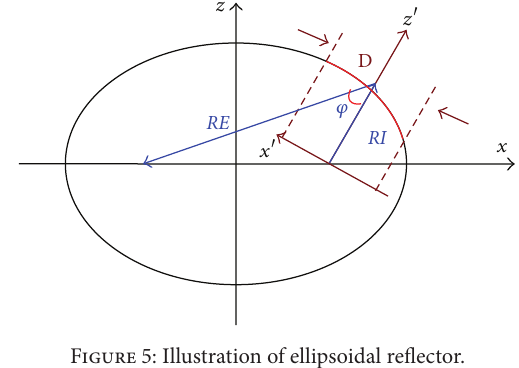
Figure 5: Illustration of ellipsoidal